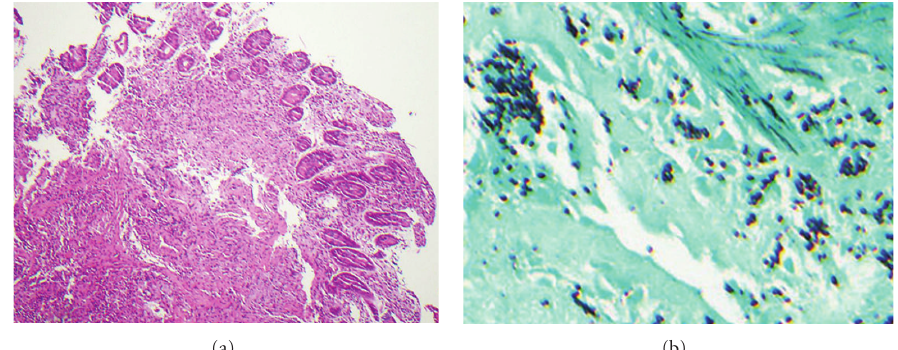
Figure 2: (a) Hematoxylin and eosin stain shows small bowel with granulomatous inflammation. (b) GMS stain highlights intracellular fungal